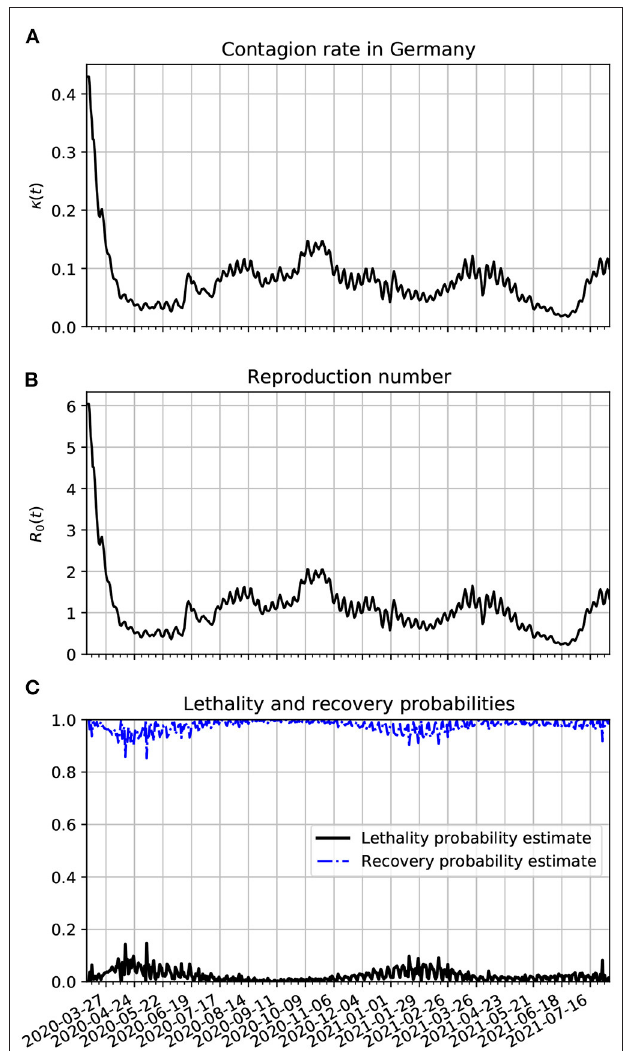
FIGURE 3 | Estimation of parameters of the epidemiological model applied to Germany. The initial date of the time series is the date in which the first death due to COVID-19 occurred in Germany. (A) the time variation of the contagion rate. The initial rate was very high, possibly due to exogenous cases in the early stages of the pandemic. To better fit the data with the predictions of our model we had to truncate κ ( t ) with values above 0.43 at the beginning of the series. (B) the reproduction number. (C) the lethality and recovery